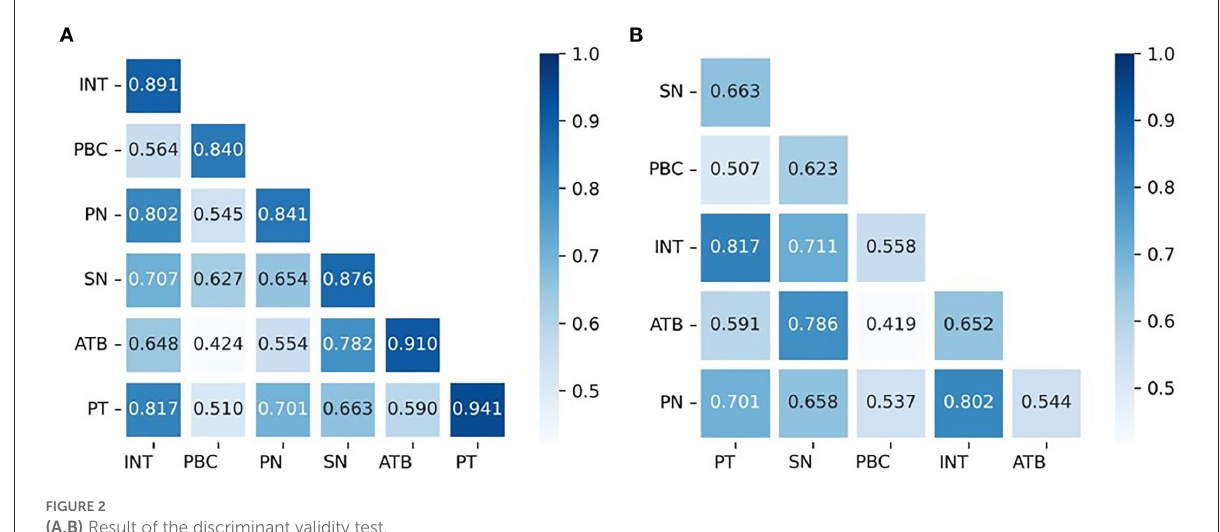
FIGURE2 (A,B) Result of the discriminant validity